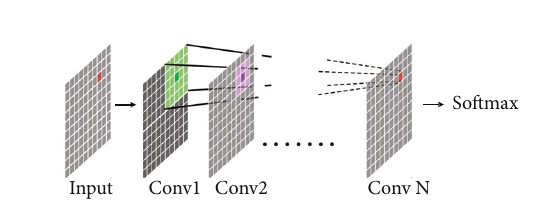
Figure 7: The architecture of the CNN (1